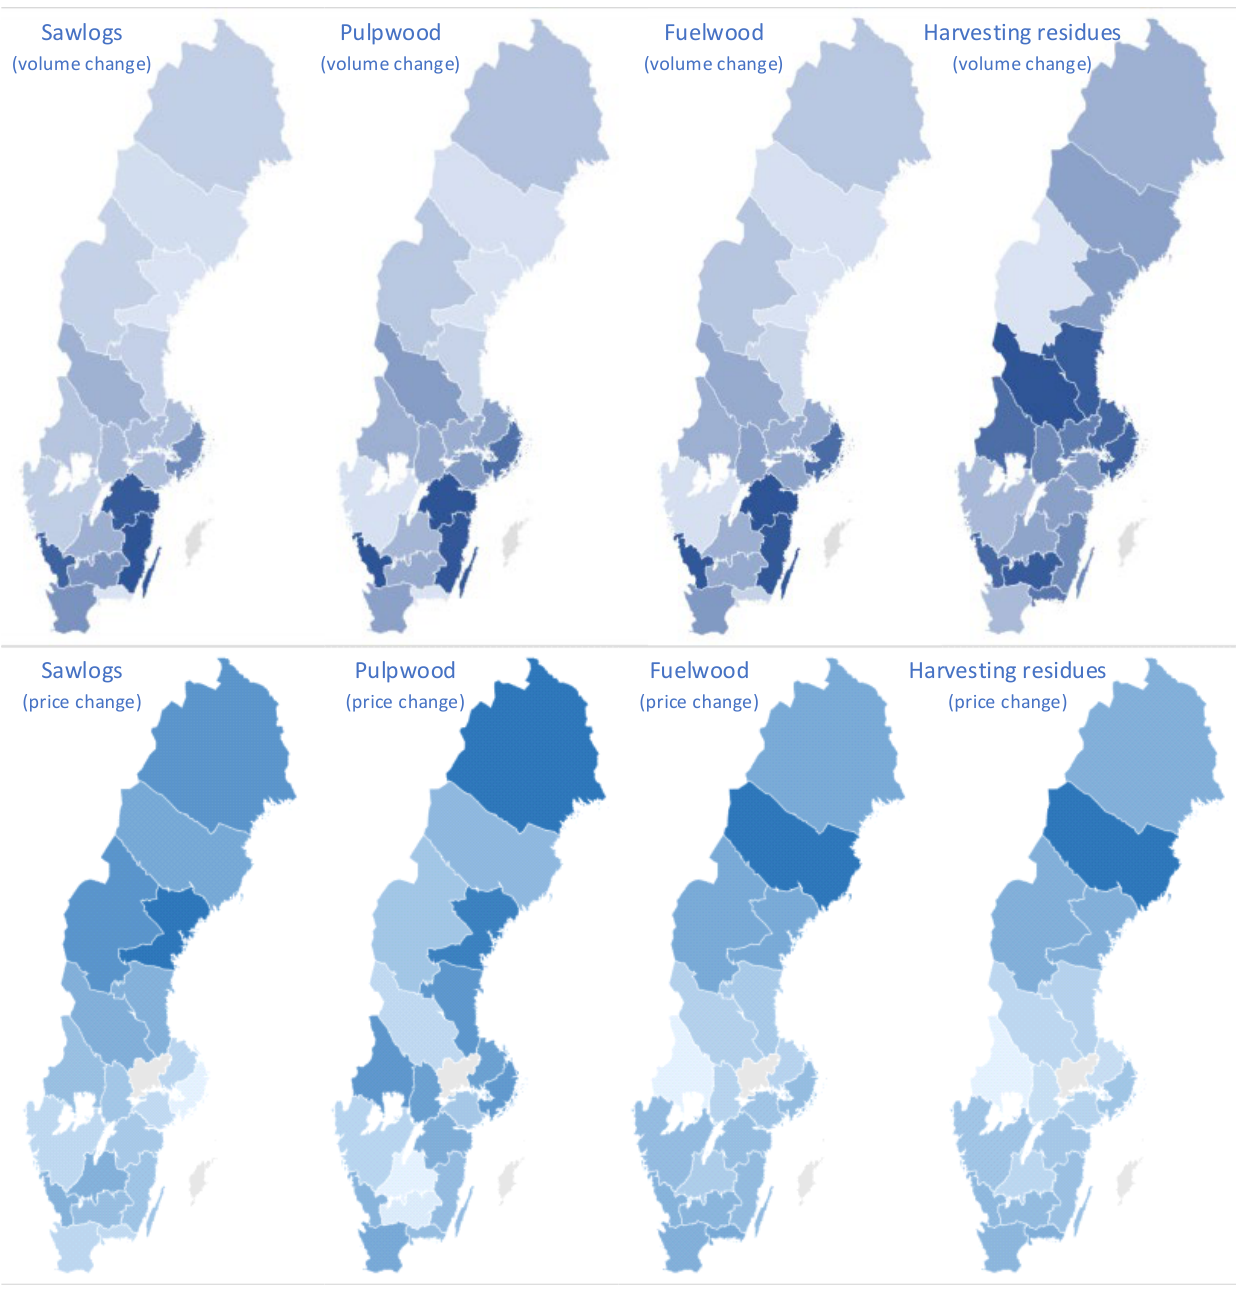
Figure 4. Spatial variation in harvesting increases and price changes. Note: Darker color indicate larger effect relative to the other counties (scaling is different between the maps).